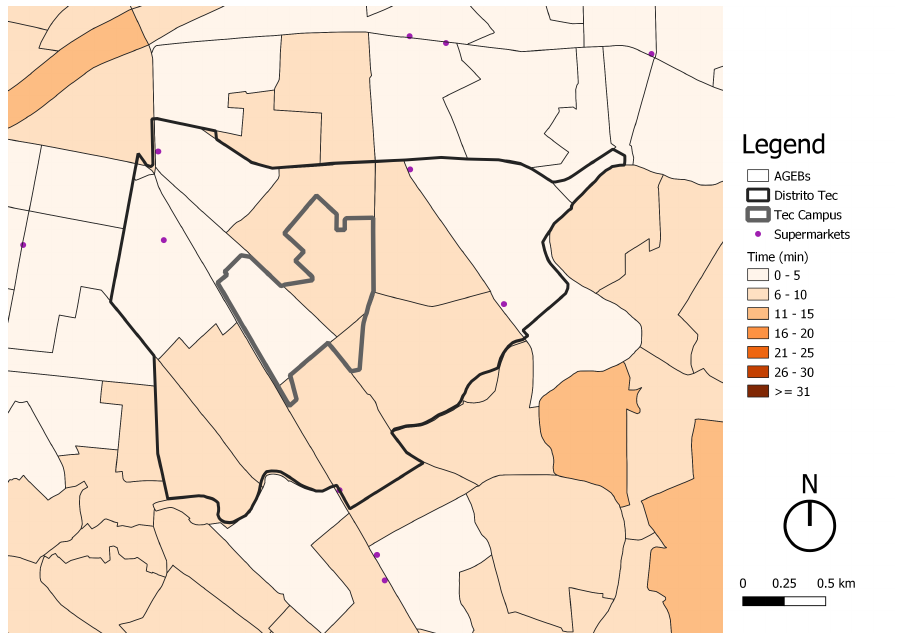
Figure 10. Distrito Tec average travel time to the closest supermarket by bicycle. Table 8. Accessibility level to supermarkets traveling by bicycle per aggregation